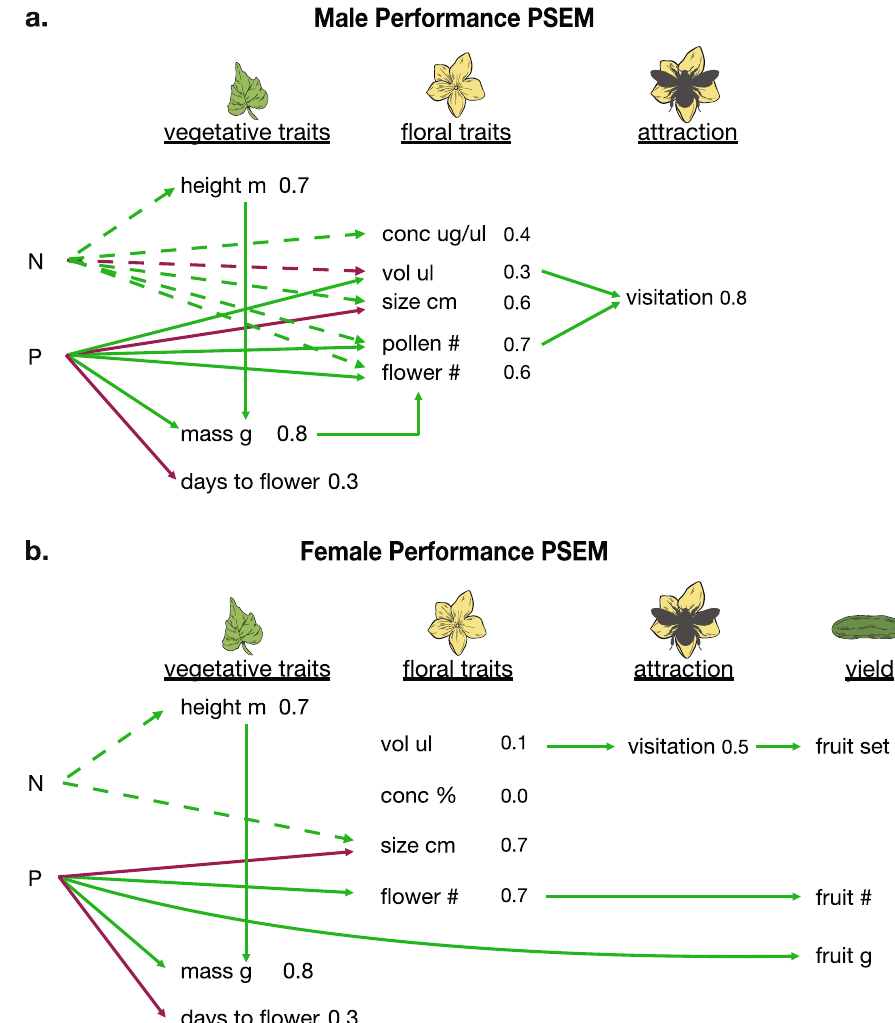
Figure 5. Piecewise SEM path analyses of soil nutrients on vegetative and floral traits, pollinator attraction/ visitation, and reproduction/yield measures for male and female traits in cucumbers. Green lines represent significant positive relationships, whilst red lines represent significant negative relationships. Nonsignificant relationships are not represented for ease of path interpretation (full model paths and details are provided in Supplementary Tables S6, S7). R 2 values for each linear regression response variable are provided. Estimated effects (including standardized estimates) for each variable are provided in Supplementary Tables S6, S7. Note how soil nutrients influence many male floral traits, yet nectar volume and pollen number were most strongly associated with male flower visitation rate, likely increasing male fitness. However, only female floral volume increased visitation rate, yet nectar volume was not influenced by changes in soil nutrient concentrations and remained consistent across treatments. Female fitness increased in three ways: (1) the path of increased soil phosphorus concentrations which in turn increased the number of female flowers, resulting in higher numbers of fruit; (2) the path of plants with higher female nectar volume having higher bee visitation rate and therefore a higher fruit set; (3) increased soil phosphorus concentrations resulting in larger